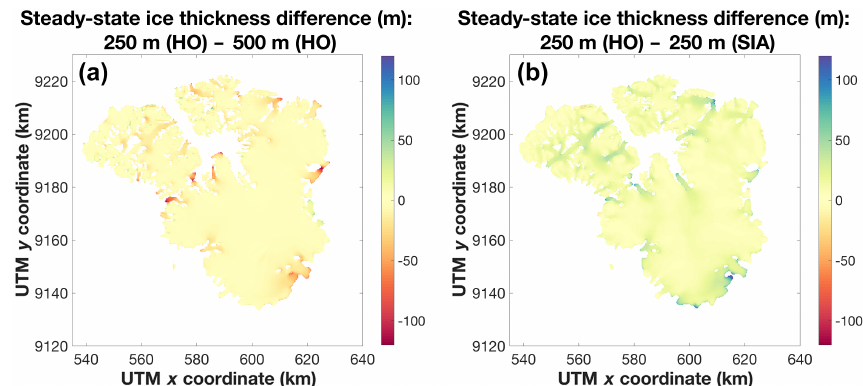
Figure 8. (a) Difference in ice thickness between 250 and 500m resolution HO steady states and (b) difference in ice thickness between HO and SIA steady states (at 250m resolution). Notice that the SMB is fixed in time (1961–1990 climatology applied on the present-day geometry) in order to avoid effects related to the SMB–elevation